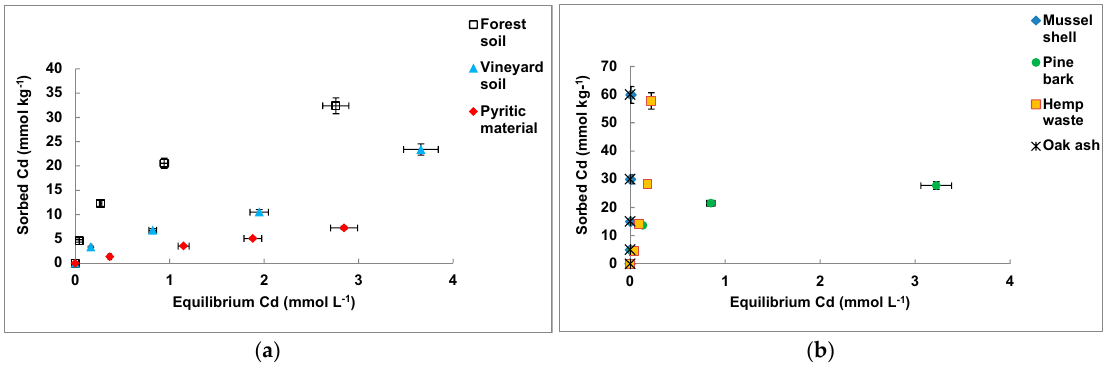
Figure 1. Cd sorption curves for forest soil, vineyard soil, and pyritic material ( a ), and for the by-products studied ( b ). Average values (with error bars) for three replicates, with coefficients of variation always <5%.